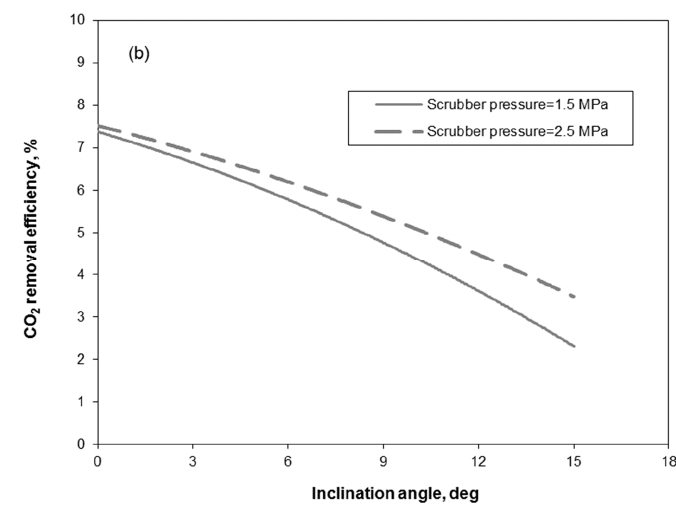
Figure 10. CO 2 removal efficiency vs. seawater scrubber inclination angle (packed-bed column with Raschig super-Rings): ( a ) H = 5 m; ( b ) H = 8 m.